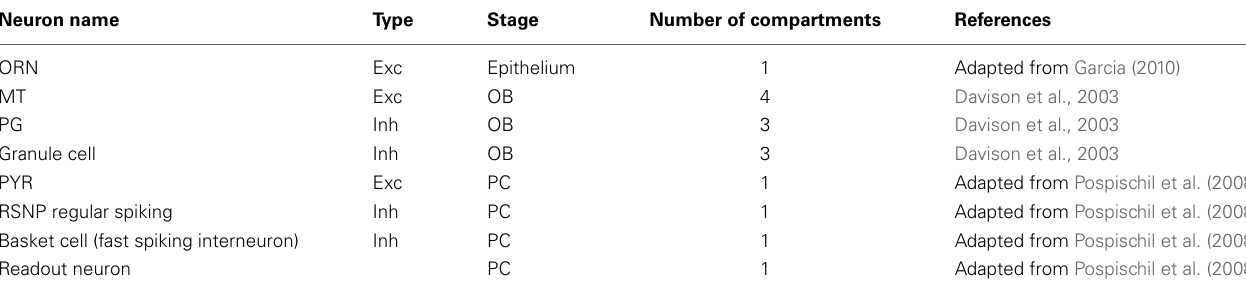
Table 1 | Neuron and synapse models and choice of